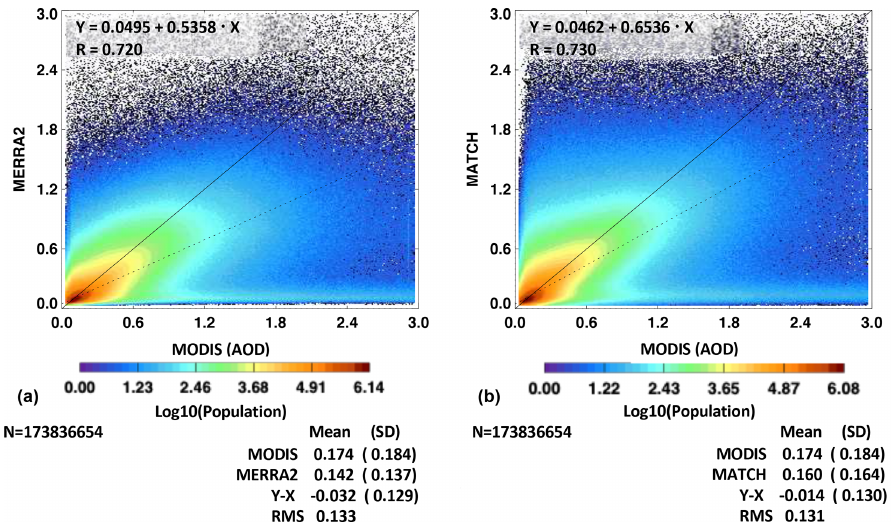
Figure 4. Scatterplot of daily 1 ◦ × 1 ◦ mean AOD from (a) MERRA-2 and (b) MATCH versus AOD derived from MODIS on Terra and Aqua for March 2000 through February 2020. MODIS AODs are 1 ◦ × 1 ◦ daily averages derived by the Dark Target and Deep Blue algorithms. Only days and grid boxes that have MODIS AOD (i.e., AOD clr , as defined in the text) are used. MODIS